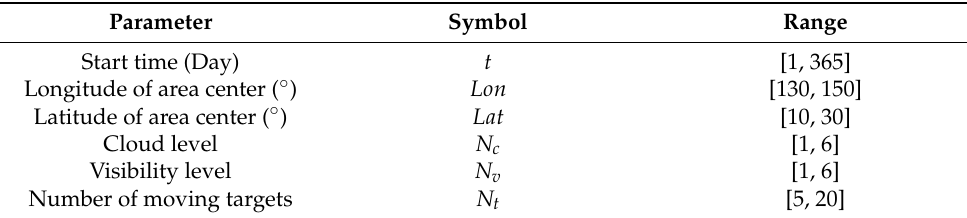
Table 7. The range of the sample input task parameters.